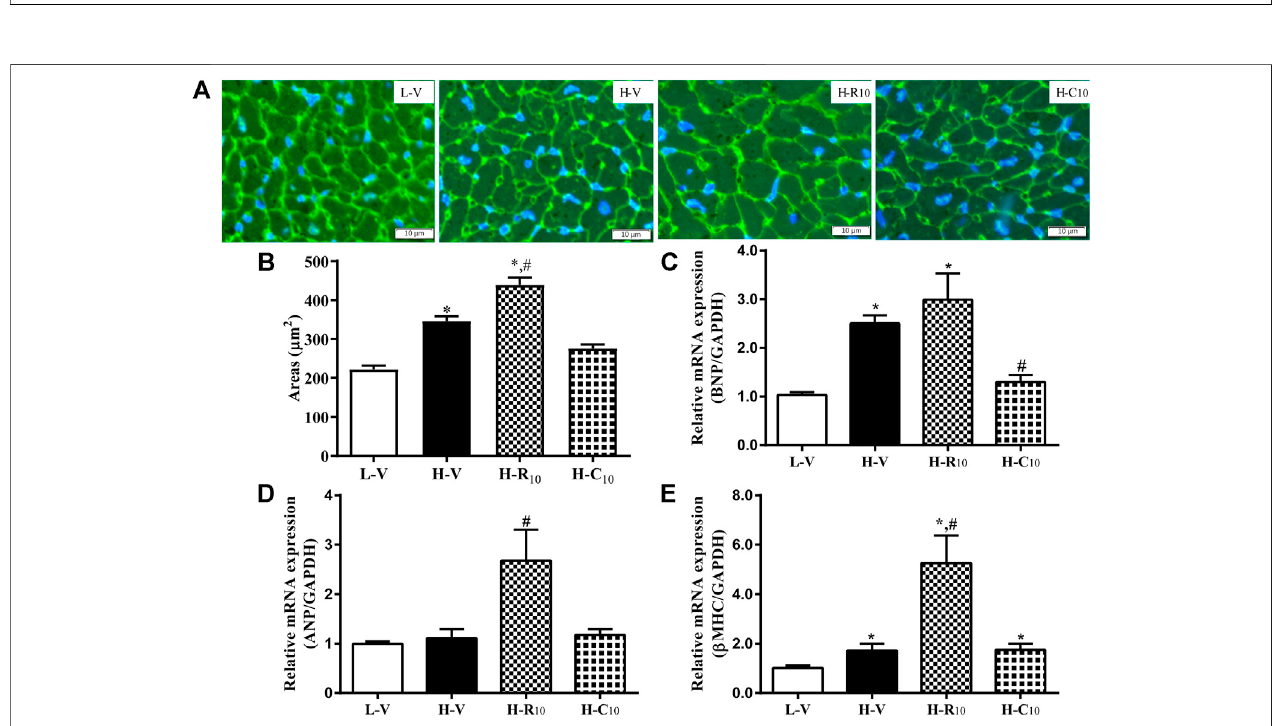
FIGURE 6 | Cardiomyocyte changes in HFD mice following treatment with CMHX008 and rosiglitazone. (A) Representative WGA staining in the heart from HFD mice following treatment with CMHX008 and rosiglitazone; (B) Quanti fi ed cardiomyocyte size; Measurement of the mRNA levels of the hypertrophic marker genes BNP (C) , ANP (D) , and β -MHC (E) in heart tissues. Means ± SEM, n (cid:2) 5 – 8 mice per group, * p < 0.05 vs. L-V, # p < 0.05 vs. H-V.